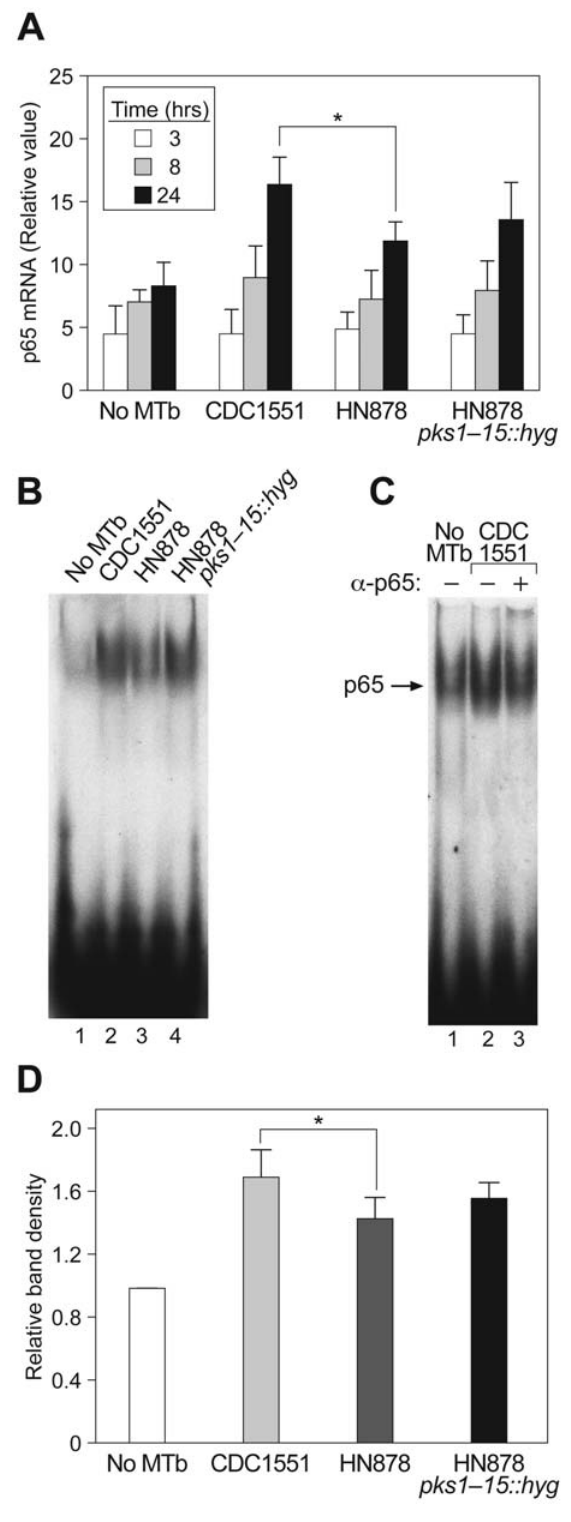
Figure 4. CDC1551 and HN878 differentially induce transcrip- tion and nuclear localization of the p65 subunit of NF- k B. (A) p65 mRNA levels in PBMC from six individual donors infected with CDC1551, HN878, or HN878 pks1-15::hyg for 3, 8 and 24 hours. There was no significant difference in p65 mRNA levels across uninfected cells and the cells infected with CDC1551, HN878, or HN878 pks1-15::hyg after 3 and 8 hours infection. A significant difference in p65